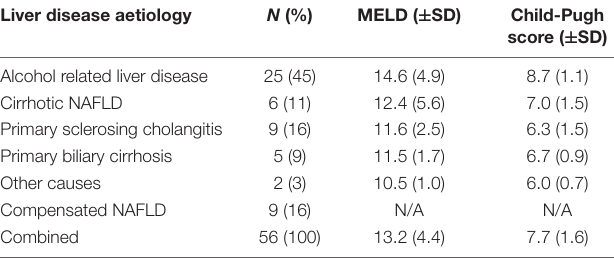
TABLE 2 | Disease aetiology for the liver disease